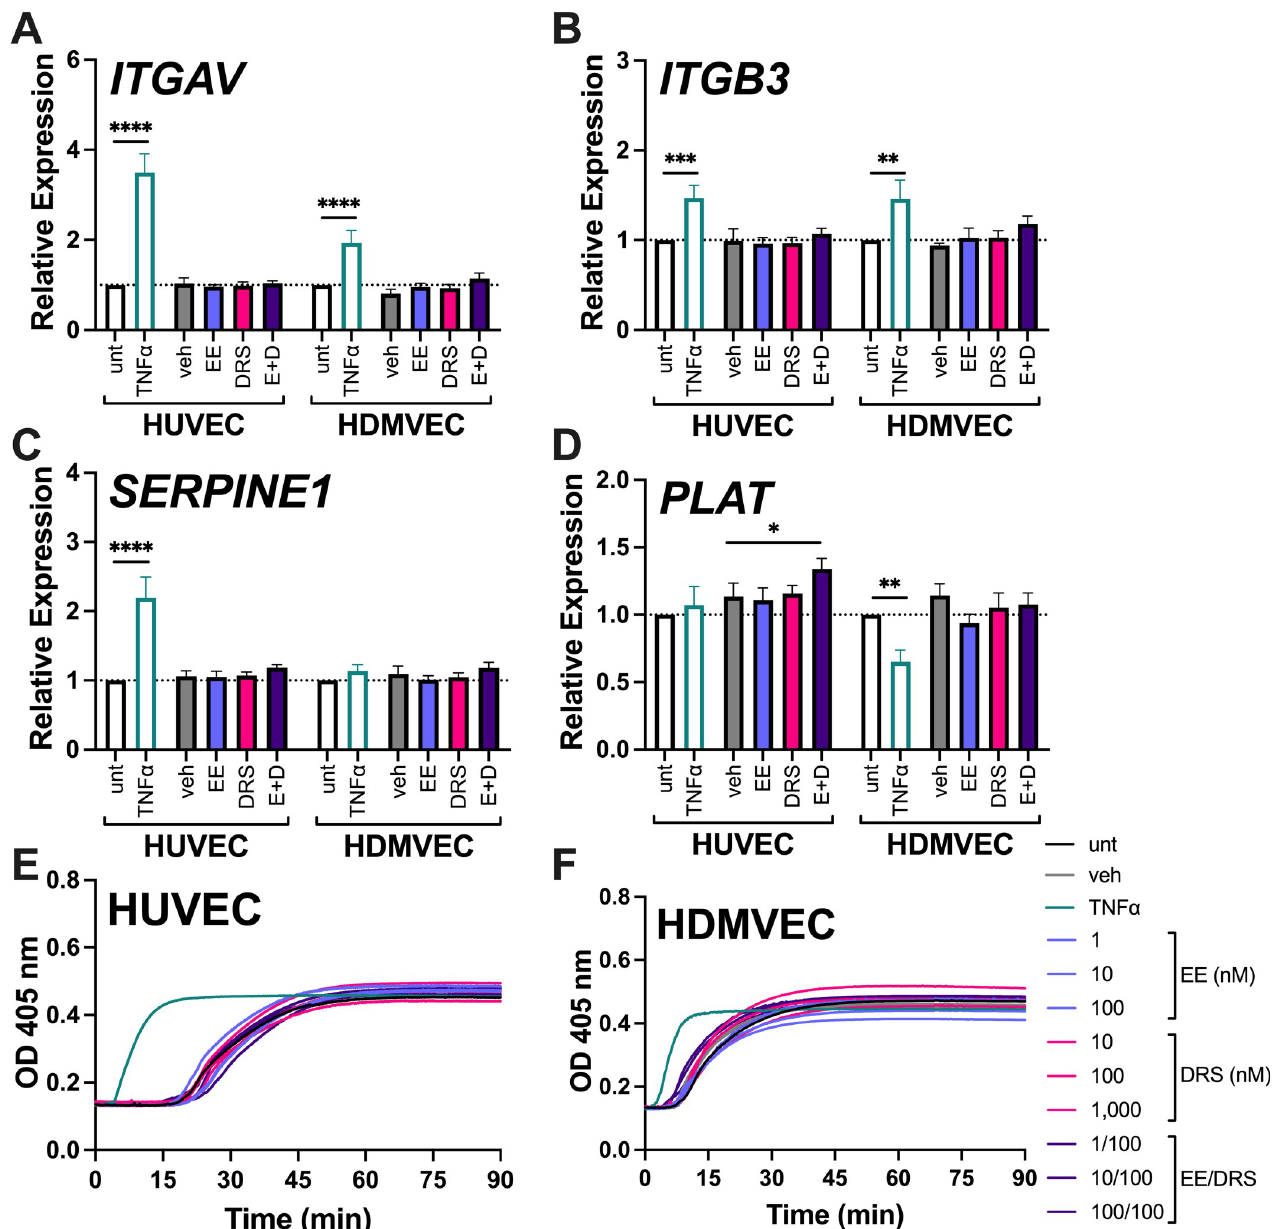
Fig 2. OC hormones do not enhance EC-supported fibrin formation. HUVEC and HDMVEC were treated with vehicle (0.7% ethanol [veh]), 10 ng/mL TNF ⍺ , 1 nM EE, 100 nM drospirenone (DRS), or EE and drospirenone (E+D) for 24 hours before RNA was extracted. Transcripts encoding (A) integrin ɑ v ( ITGAV ), (B) integrin β 3 ( ITGB3 ), (C) plasminogen activator inhibitor type I ( SERPINE1 ), and (D) tissue plasminogen activator ( PLAT ) were measured by RT-qPCR and normalized to the untreated control (N = 3–12; Bars = mean + SEM). TNF ɑ was compared to untreated cells, whereas EE and drospirenone treatments were compared to vehicle ( * p < 0.05, *** p < 0.001, **** p < 0.0001). After 24 hours of TNF ɑ , EE, and/or drospirenone treatment, fibrin formation initiated by (E) HUVEC and (F) HDMVEC was measured by turbidity in recalcified NPP (curves representative of N = 4–5). Fibrin formation parameters and statistical analyses are provided in S2